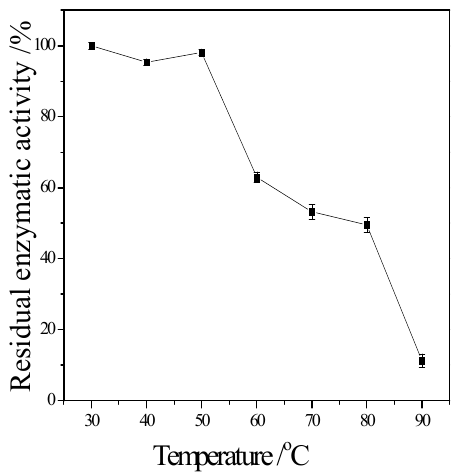
Figure 5. Thermal stability of the cellulose.